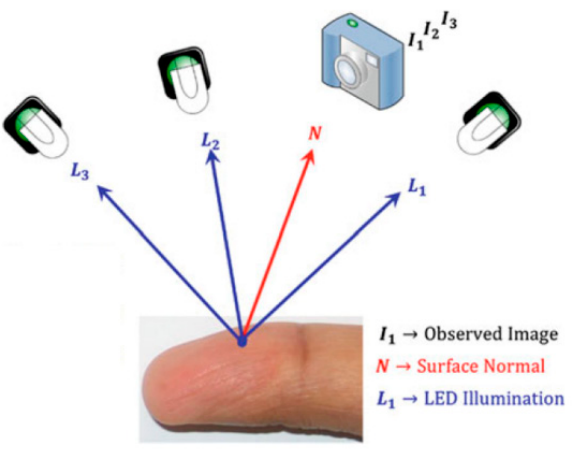
Figure 6. Acquisition of 3D fingerprint using photometric stereo techniques [39].